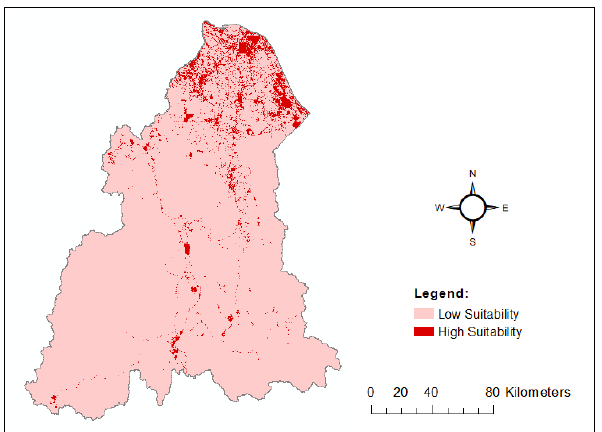
Figure 3. Suitability parameters: Red Cells are suitable for urban development, and Pink Cells are not suitable for urban development.